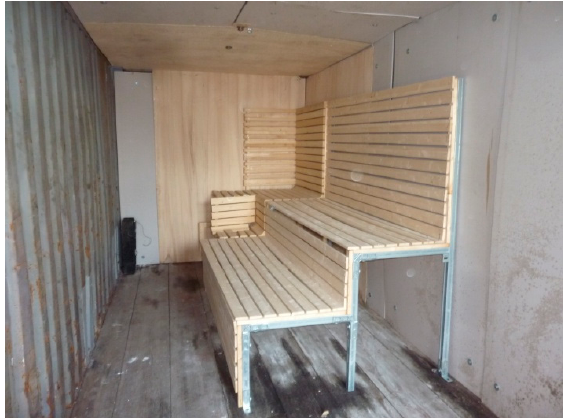
Figure 2. Test chamber: benches and drywall/plywood boards.